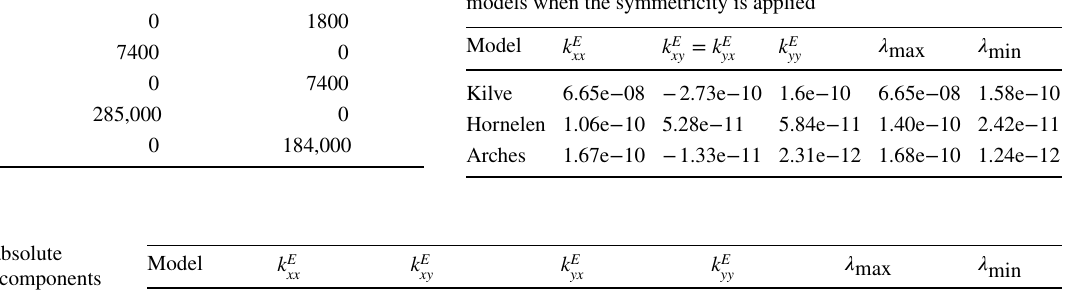
Table 4 Ensemble absolute permeability tensor components of the models when the symmetricity is not applied